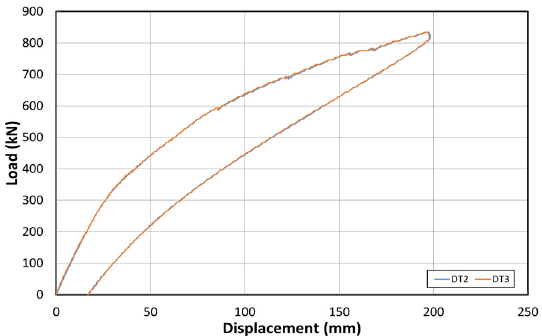
Figure 15. Load–displacement curve after reinforcement based on the EP method.